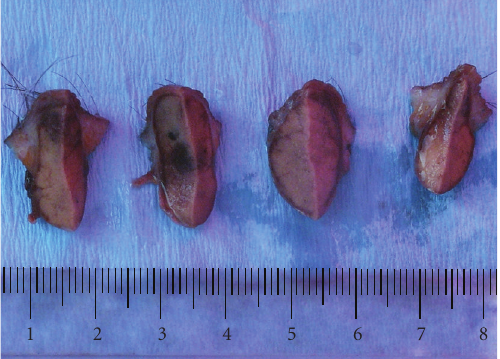
Figure 1: Macrophotograph showing solid tumoral lesion in subepidermal area. A slice of the lesion contained some regions of